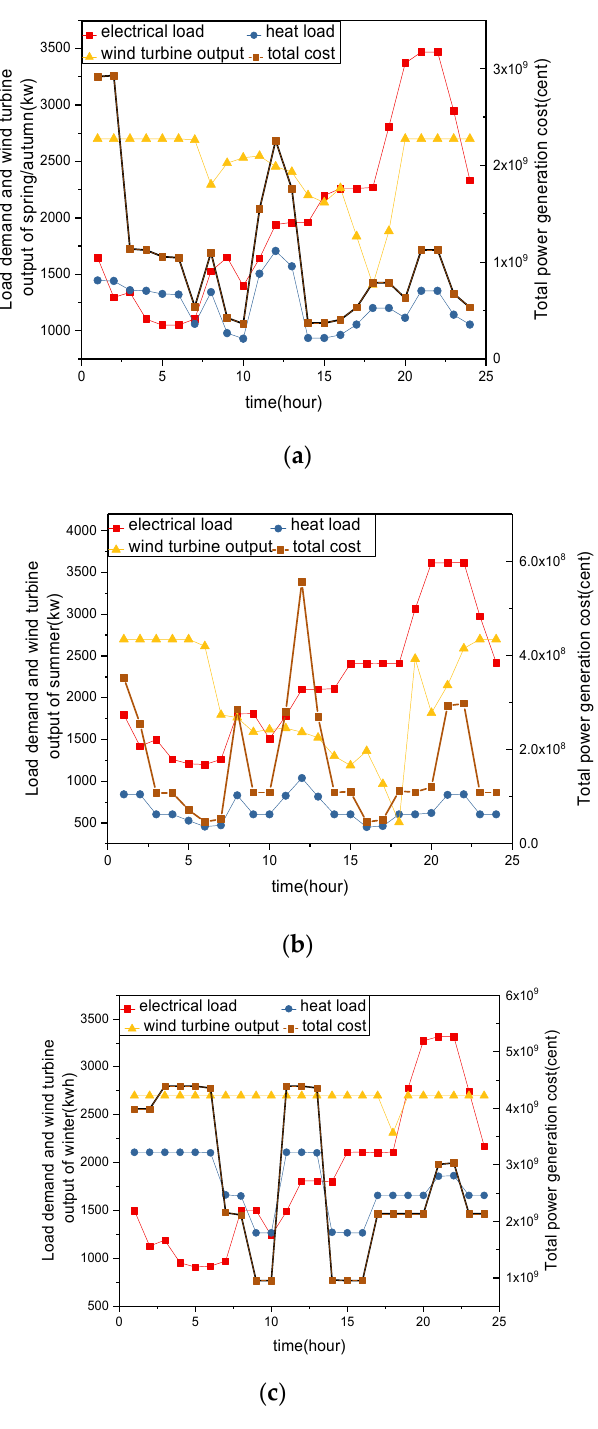
Figure 11. 24-h variation of total cost, total electrical load, total wind turbine output, and total heat load in di ff erent seasons: ( a ) spring and autumn; ( b ) summer; ( c ) winter.